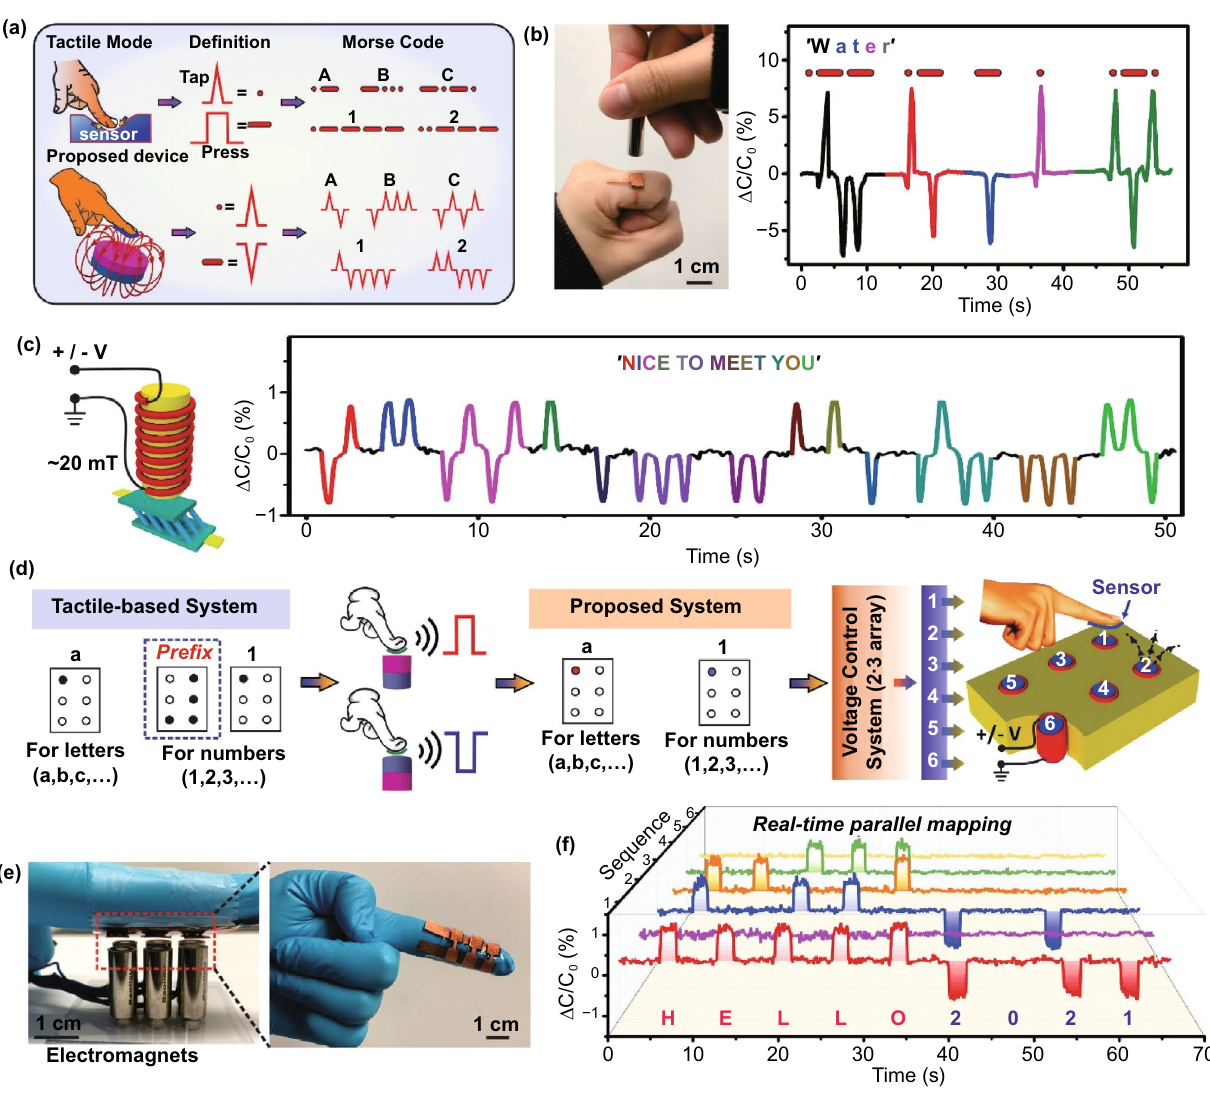
Fig. 4 a Schematic of touchless Morse code communication by simply switching the orientation of magnetic field based on our proposed sen- sor. b Real-time monitoring of the Morse code transmission of ‘water’. c Programmable Morse code transmission of ‘Nice to meet you’. d Schematic of the touchless, efficient, convenient, and programmable Braille interaction system based on our proposed sensor. e Photograph of the proposed Braille interaction system. f Real-time mapping of capacitance signals regarding the electromagnetic fields to decode the Braille information of ‘HELLO